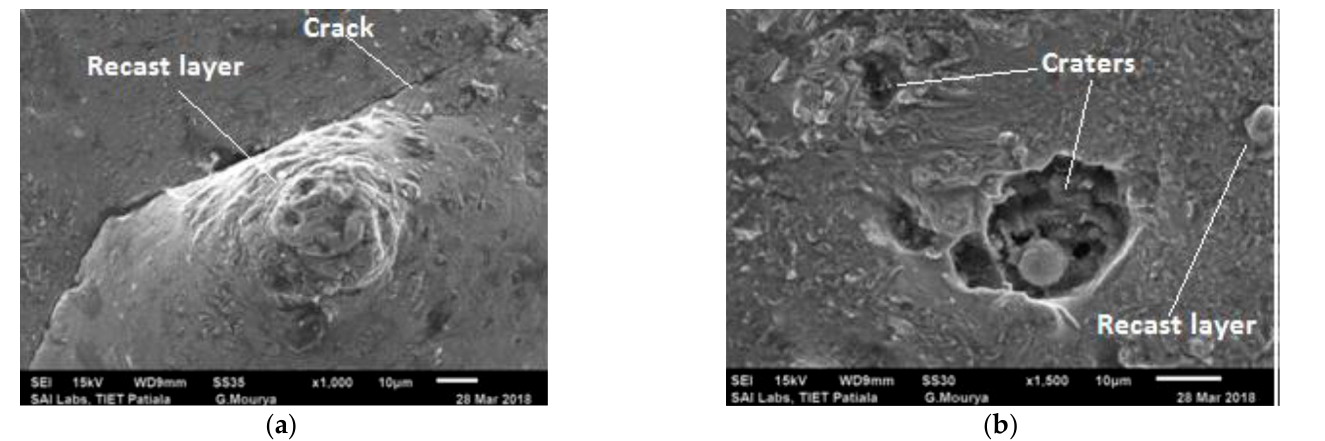
Figure 9. Surface characteristics of the workpiece after EDM ( a ) for Experiment 20 ( b ) for Experiment 5.